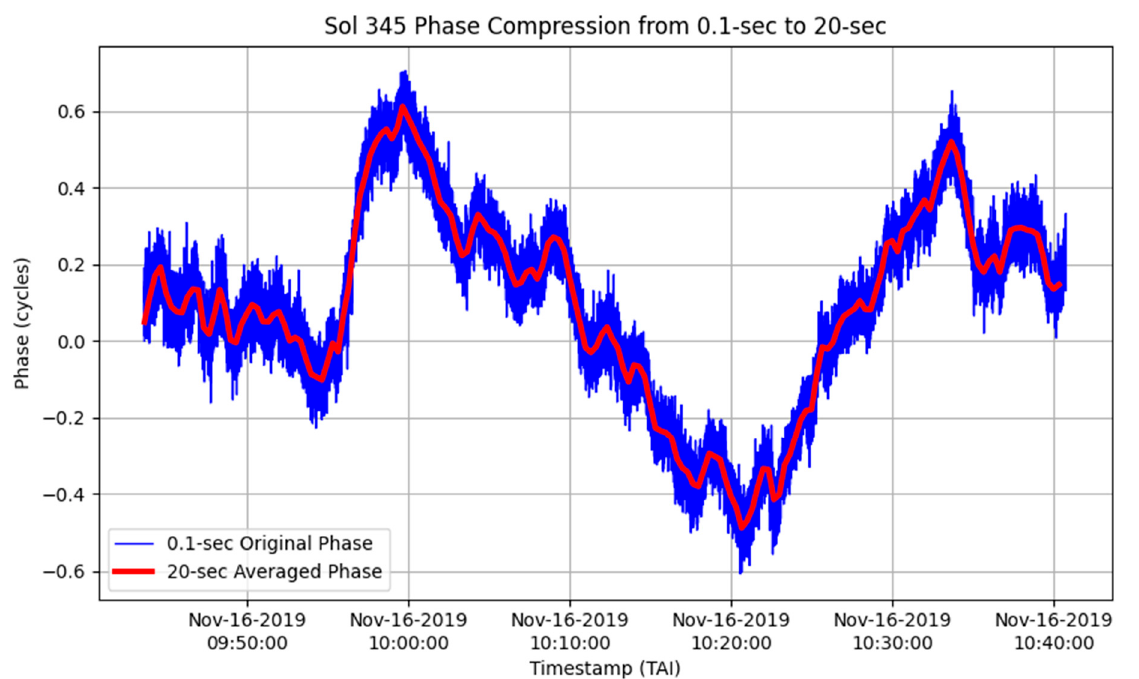
Figure 4. Residual phase at the original 0.1 s count-time and the resulting averaged phase residuals at a 20 s integration time for the Sol 345 pass.